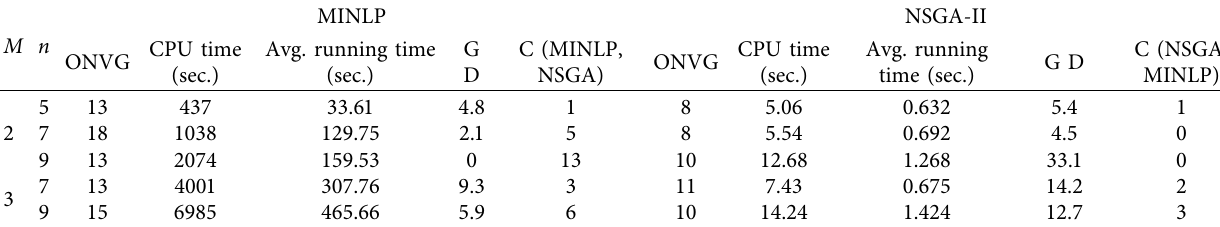
Table 2: Comparison of MINLP and NSGA-II results. MINLP NSGA-II M n CPU time ONVG (sec.)